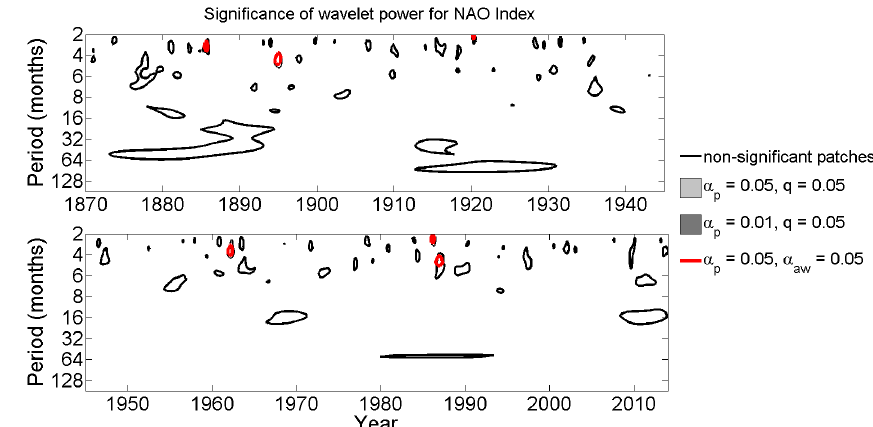
Figure 3. Significance of wavelet power for the NAO index mean monthly values for the period 1870–2013. Black contours enclose regions of 5% pointwise significance (see Sect. 3.1) and thick red contours are the 5% areawise significant subsets (see Sect. 3.2). Light gray shading indicates those 5% pointwise significance patches that are geometrically significant at the q = 0 . 05 level and dark gray shading indicates those 1% pointwise significance patches that are geometrically significant at the q = 0 . 05 level.